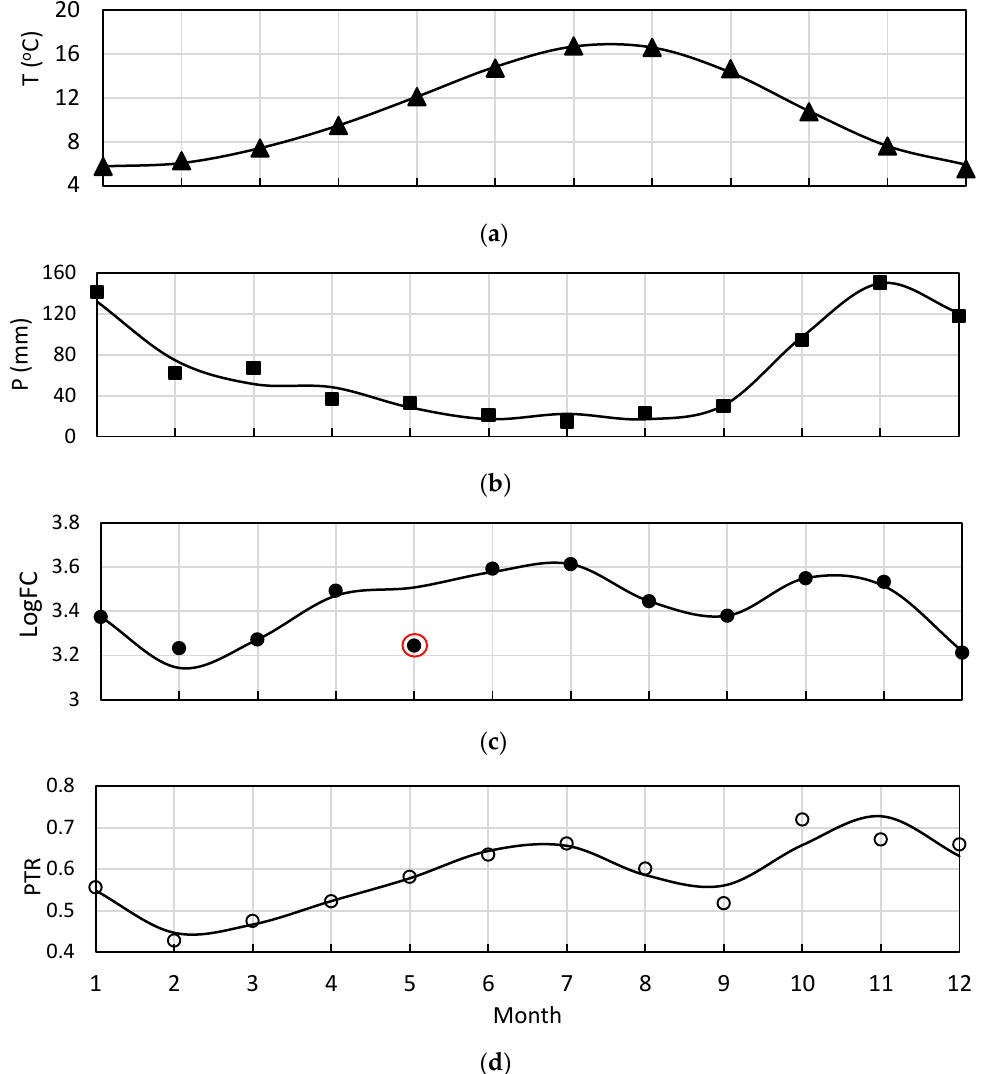
Figure 6. ( a ) Monthly temperature averaged over the entire 17 year period with fitted Fourier model shown as the solid line; ( b ) monthly averaged precipitation with Fourier model; ( c ) Log FC m with fitted Fourier model and ( d ) PTR versus month with fitted Fourier model.